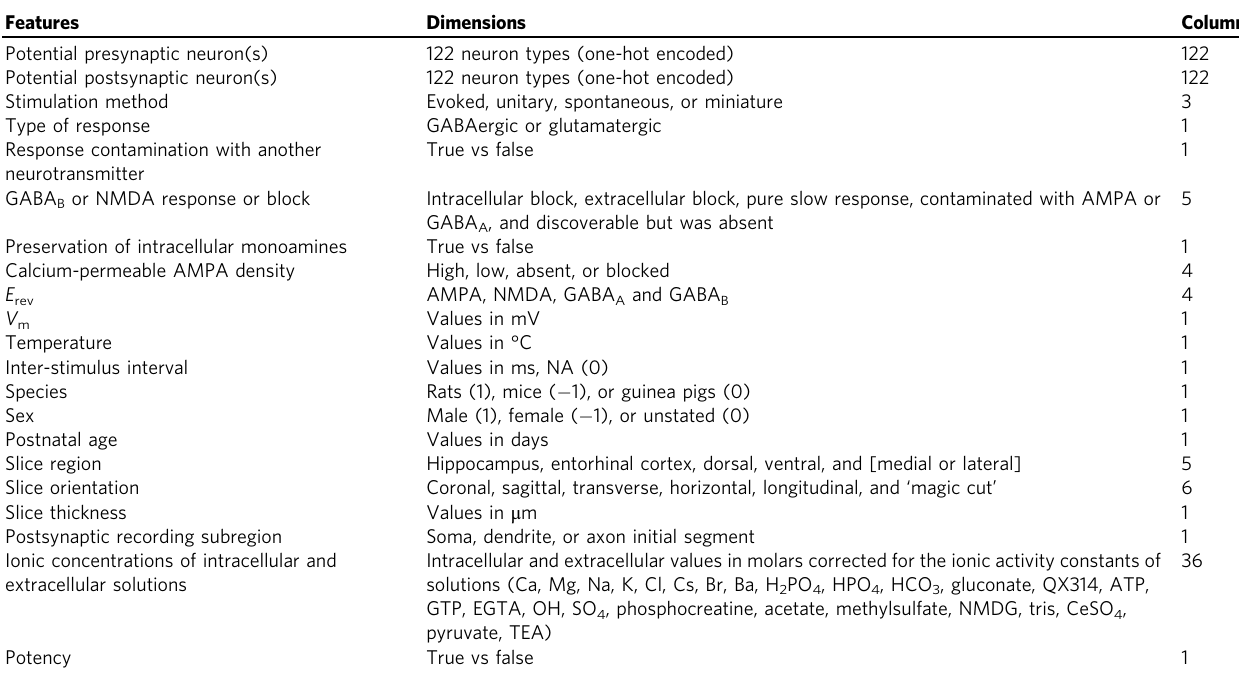
Table 1 List of features used for machine